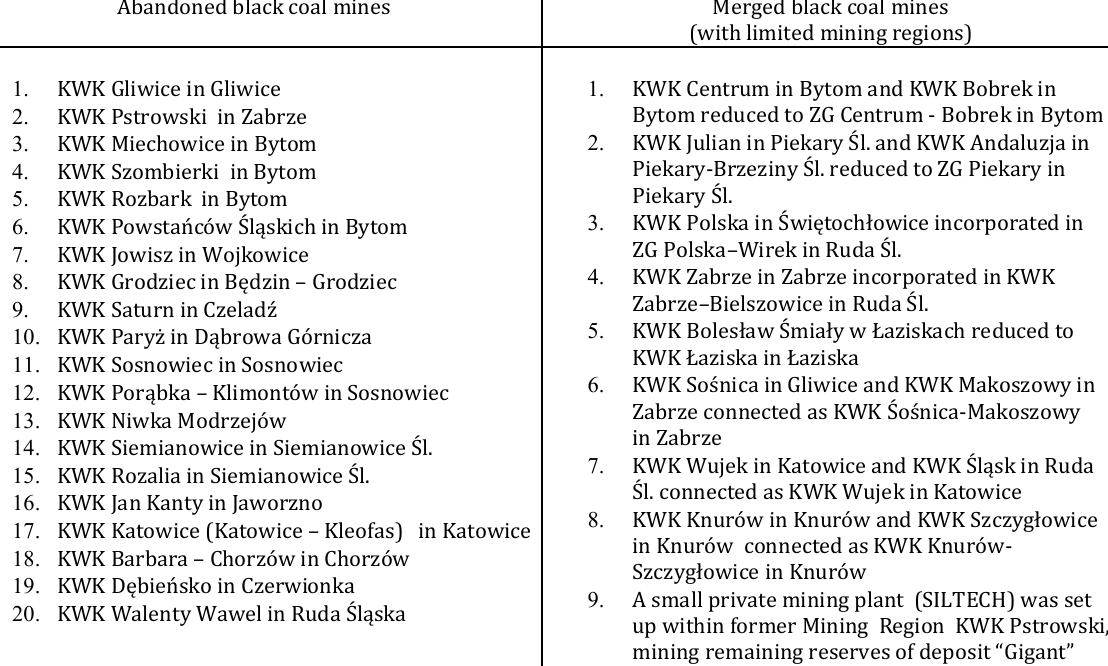
Table 1. Abandoned and combined black coal mines in the Katowice conurbation (made by the author on the base of Bilans zasobów kopalin,